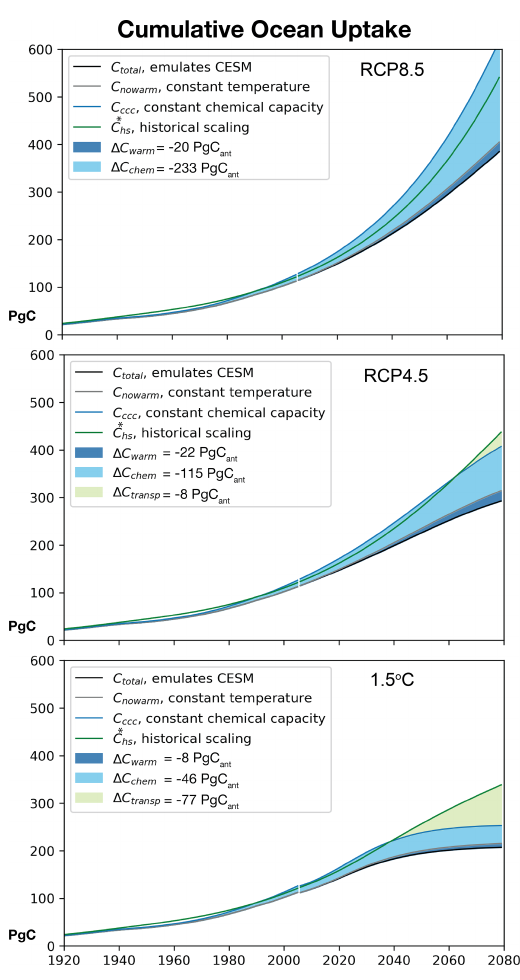
Figure 5. Cumulative ocean anthropogenic carbon uptake (Pg C ant ) in the IRF model: historical and for three future scenarios. The ∗ C hs ). The dark blue line is the green line is the historical scaling ( IRF model simulation of constant chemical capacity with no impact of warming on solubility and inorganic carbonate chemistry ( C ccc ). The gray line is the IRF simulation with no impact of warming on solubility and inorganic carbonate chemistry ( C warm ). The black line is the IRF model simulation that includes all effects ( C total ) (variable chemical capacity and warming impacts on solubility and inorganic carbonate chemistry); this model closely replicates the cu- mulative carbon uptake of CESM (Fig. 2d). Light green shading represents the residual, estimating the decrease in uptake related to vertical C ant transport ( (cid:49)C transp ) for RCP4.5 and the 1.5 ◦ C sce- nario. Light blue shading represents decreases in uptake related to chemical capacity ( (cid:49)C chem ). Dark blue shading indicates the de- crease due to warming impacts on solubility and inorganic carbon- ate chemistry ( (cid:49)C warm ). For each scenario, the carbon uptake from 2020 to 2080 is indicated in the label, with negative indicating loss relative to the total potential